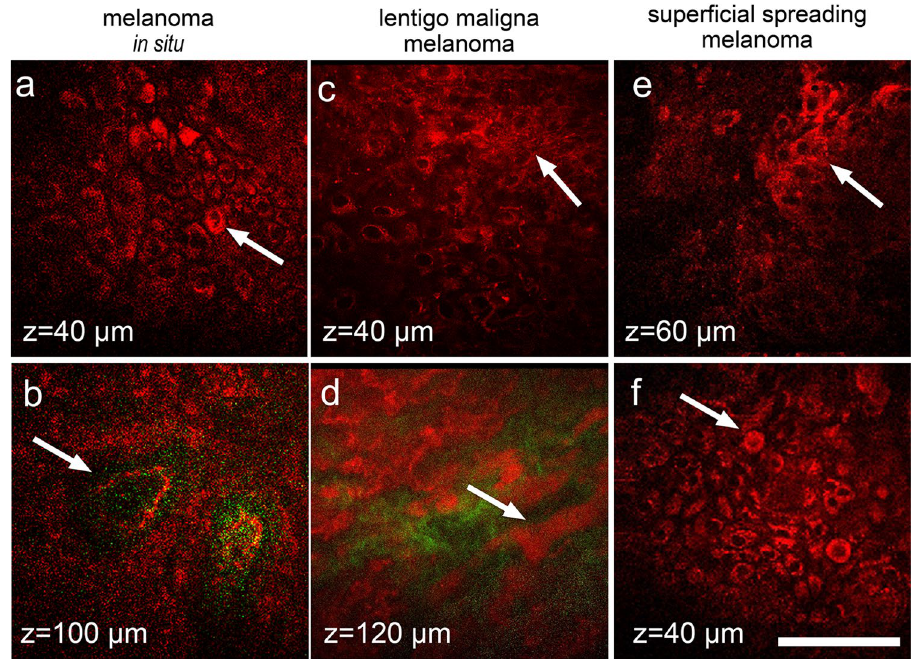
Figure 4. MPM features of melanoma in dermoscopic equivocal group. In melanoma in situ , large pagetoid cells in spinous layer (arrow, a ) and non-edged papillae (arrow, b ) are marked. In lentigo maligna melanoma, large pleomorphic cells in spinous layer (arrow, c ) and melanophages below dermal–epidermal junction (arrow, d ) are marked. In superficial spreading melanoma, nest of atypical cells (arrow, e ) and round pagetoid cells (arrow, f ) in the epidermis are marked. Autofluorescence from the cells (red) and SHG signal from collagen (green) are shown. Imaging depth is marked on the images. Scale bar is 100 µm, applicable to all